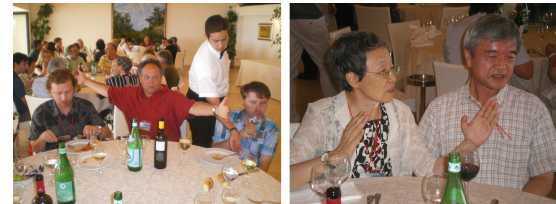
Figure 7: Are these conference participants both showing their estimate of the accretion disk radius?